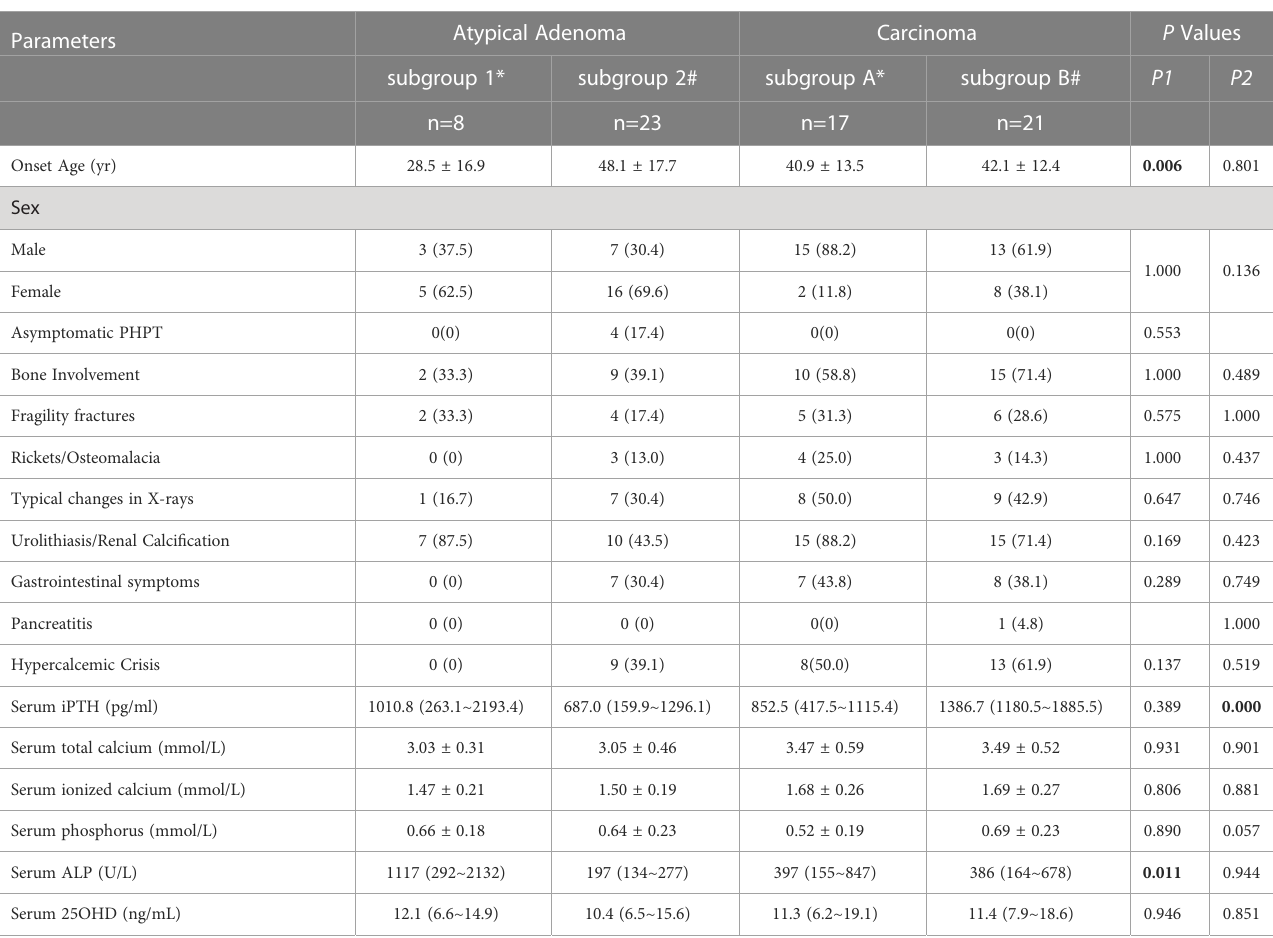
TABLE 4 Comparison of clinical characteristics and outcomes between patients with nonsynonymous variations and without such